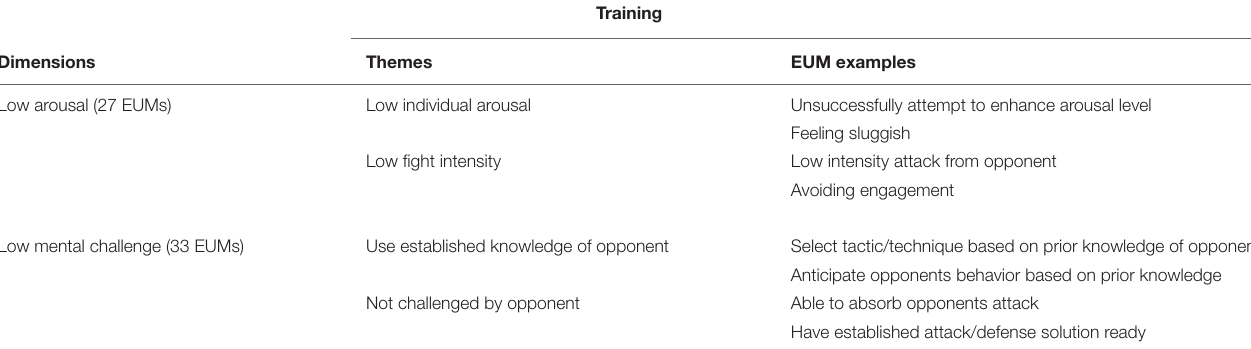
TABLE 5 | Synthesized interview data from the training condition relating to affective-cognitive differences between